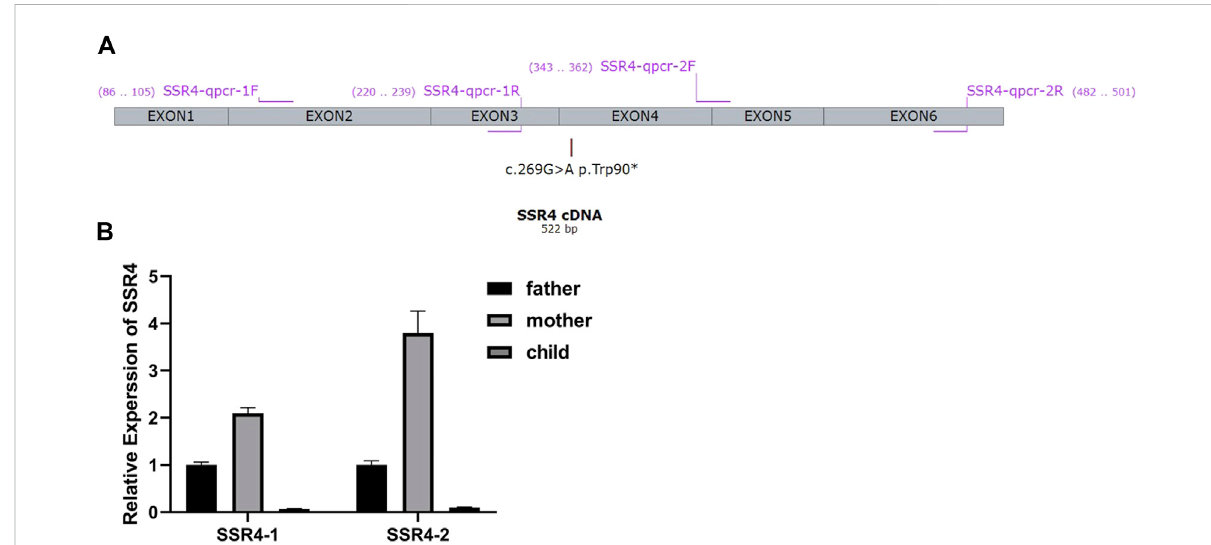
FIGURE 2 (A) Primer design for qPCR According to the gene sequences upstream and downstream of the mutation site, two pairs of primers were designed using Primer fi ve software. Primers speci fi cally amplify the target region of the SSR4 gene. The length of the ampli fi ed product is in the range of 100-200bp. The product cannot form secondary structures. (B) mRNA expression. Expression levels were analyzed with normal males (father of the proband) as